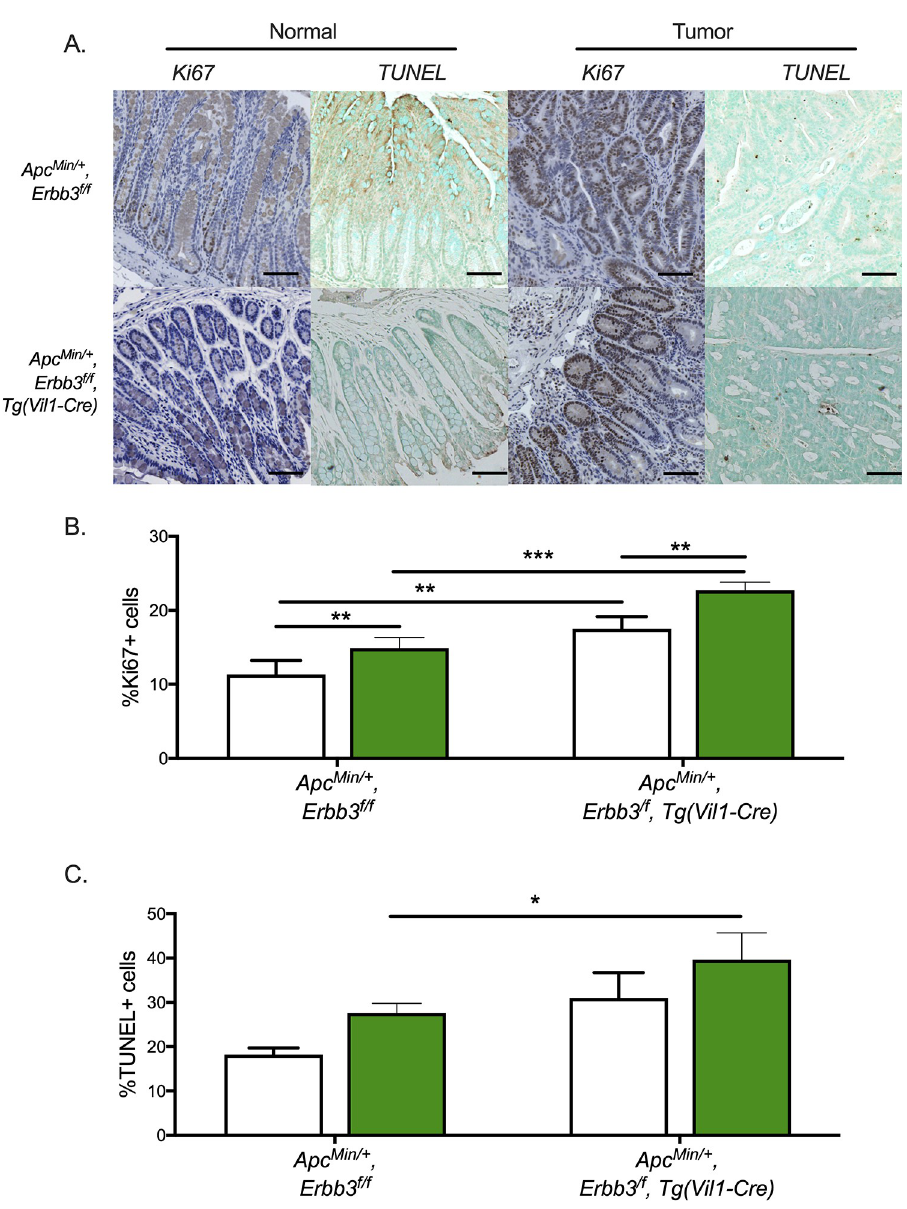
Fig 3. Cellular effects of ERBB3-deficiency on a C57BL/6J background. (A) Staining for proliferative (Ki67) and apoptotic (TUNEL) cells in polyps and adjacent normal tissue. Quantitative comparison of (B) Ki67 and (C) TUNEL counts in tumor and adjacent normal intestinal tissue. White, adjacent normal; green, polyp. p-value < 0.05, �� p- value < 0.01, ��� p-value < 0.001.